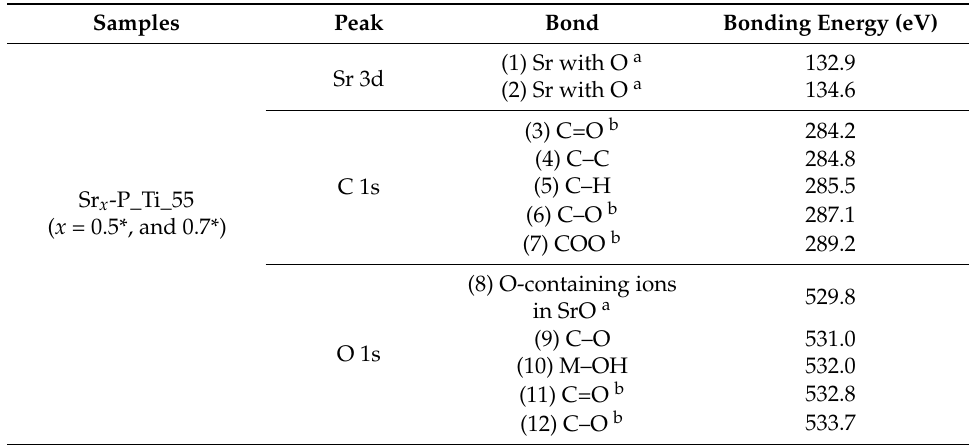
Table 1. The binding energies and related peaks (deconvoluted) for the chemical states of Sr, C, and O elements. Samples